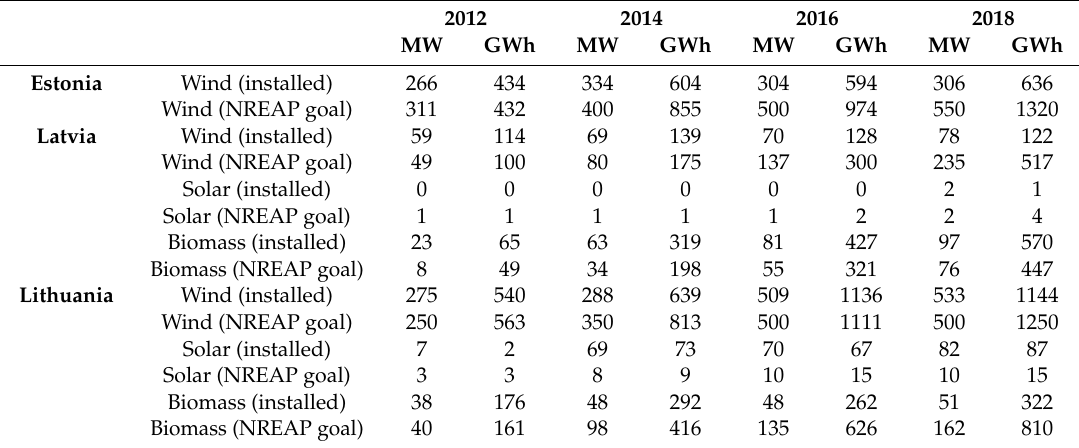
Table 2. The installed capacity and electricity generation from renewable energy sources with comparison to the national renewable energy action plan (NREAP) targets in Estonia, Latvia, and